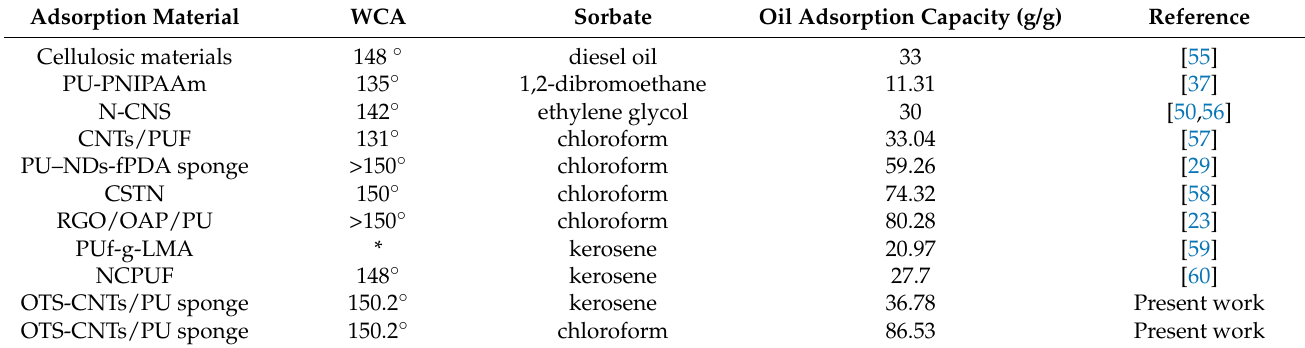
Figure 10. Variations in absorption capacities of OTS-CNTs/PU sponge for various oils under 10 cycles: ( a ) soybean oil; ( b ) kerosene; ( c ) chloroform; ( d ) petroleum ether; ( e ) hexadecane; and ( f ) crude oil. Table 5. WCA and oil absorption capacity of different absorbent